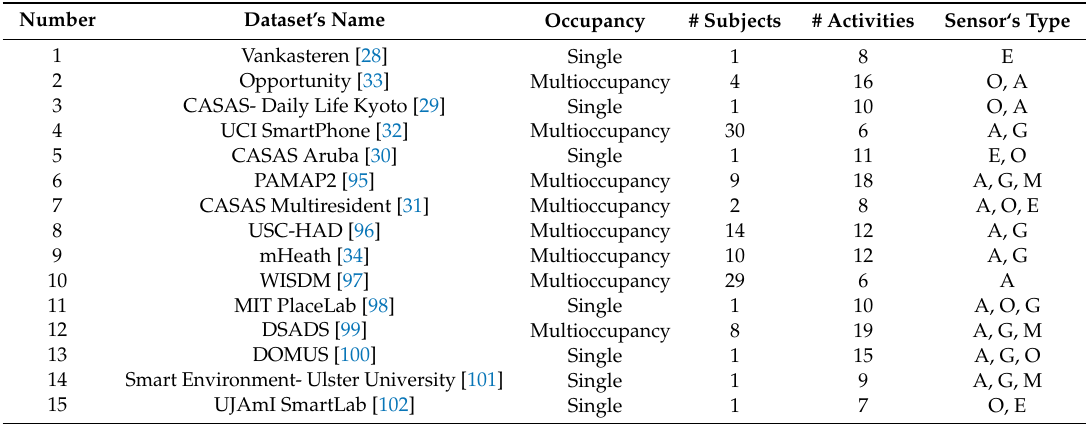
Table 5. Dataset’s